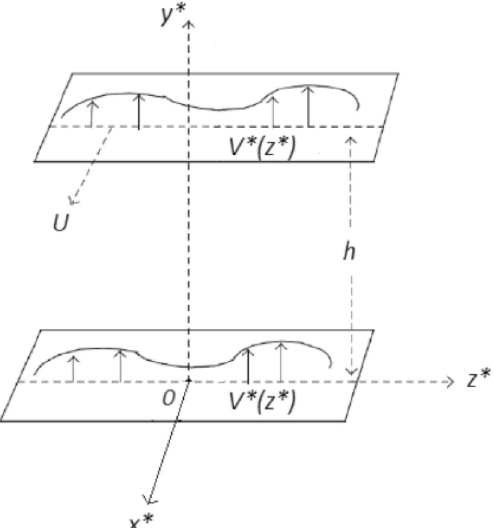
Fig. 1 Schematic of the problem (cid:4) I denote the dynamic viscosity, the pressure, the ratio of relaxation time to in which μ , p , λ 1 , λ 2 and